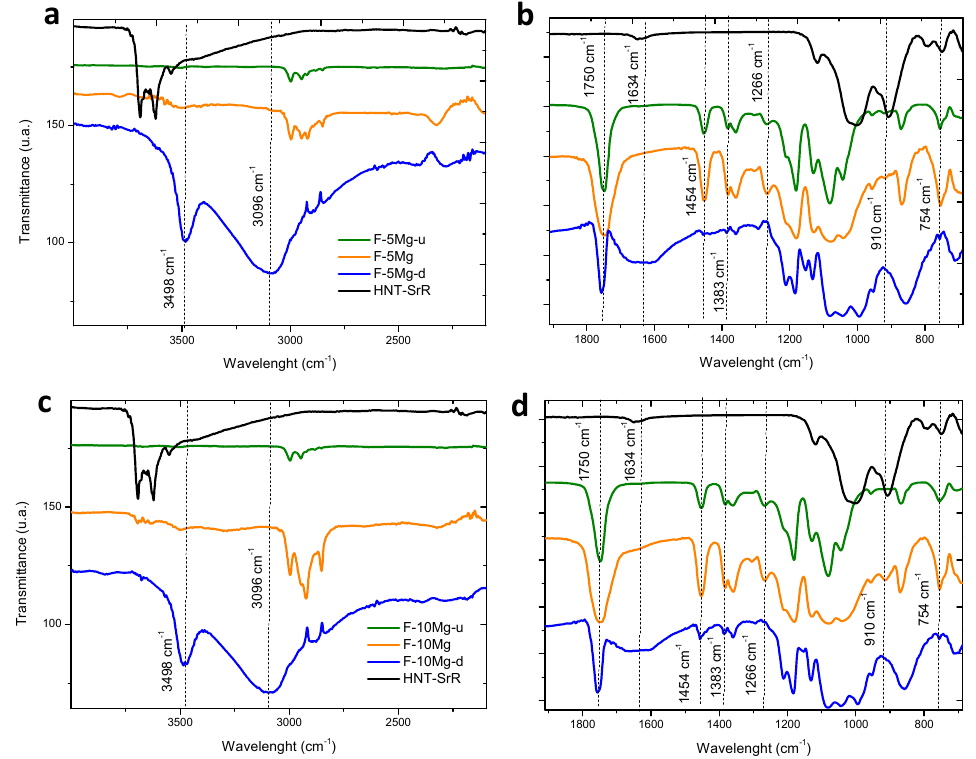
Figure 9. Depicts the complete FTIR spectra of F-5Mg-u, F-5Mg, and F- 5Mg-d ( a , b ) composites and F-10Mg-u, F-10Mg, and F-10Mg-d ( c , d ) films. Additionally, different bands of PLA, such as the band at 1383 cm − 1 attributed to the CH 3 group or the peak at 1266 cm − 1 linked to the terminal -OH bonds, which are displaced or decreased their intensity in the granulated composite, disappear after the degraded films. Bands at 1454 cm − 1 are related to PLA and also disappear during the degradation. 910 cm − 1 and the peak at 754 cm − 1 , which correspond to the Si–O perpendicular stretching and could be also related to Mg interaction, also disappear after the immersion. These results show that the high degradation status of the composite induces the release of HNT and and SrR.